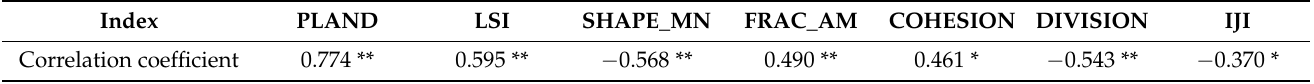
Table 2. Pearson’s Correlation Coefficients of Range Parameters and Selected Landscape